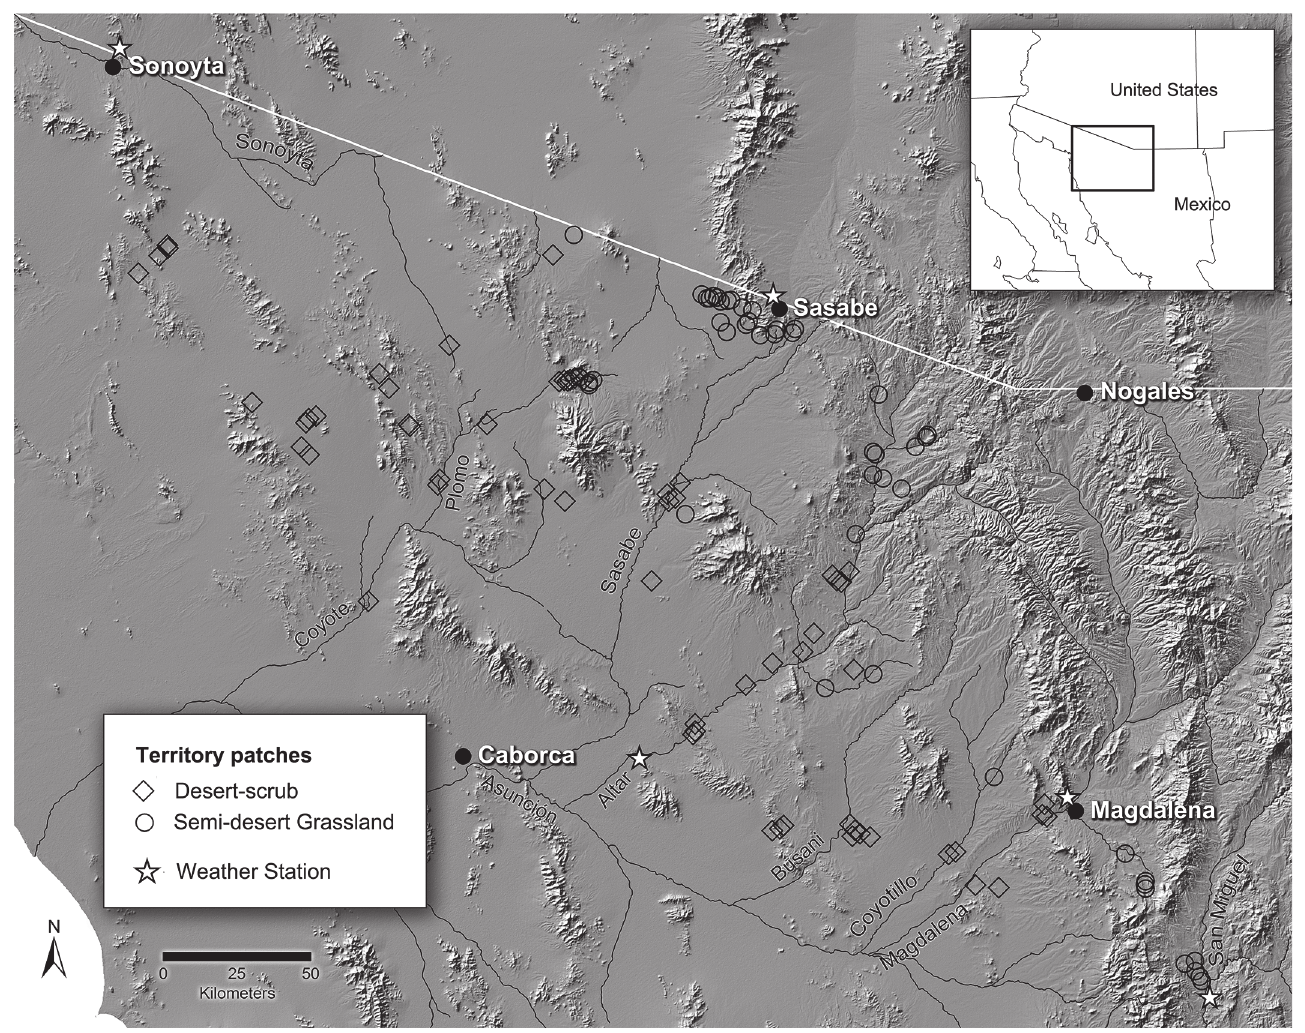
Fig 1. Study area in northwest Mexico showing distribution of territory patches used by ferruginous pygmy-owls and the location of weather stations. Territory patches were located in two major vegetation communities and weather stations were located near Sasabe, Sonoyta, Cucurpe, Magdelena, and Altar. Regional patch occupancy was estimated in 11 regions: San Miguel, upper Magdalena, Magdalena-Coyotillo, Busani, upper Alter, lower Altar, upper Sasabe, lower Sasabe, upper Plomo, lower Plomo, and Sonoyta. Territory patches were 50 ha in area and are not shown to scale; the study area was approximately 20,000 km 2